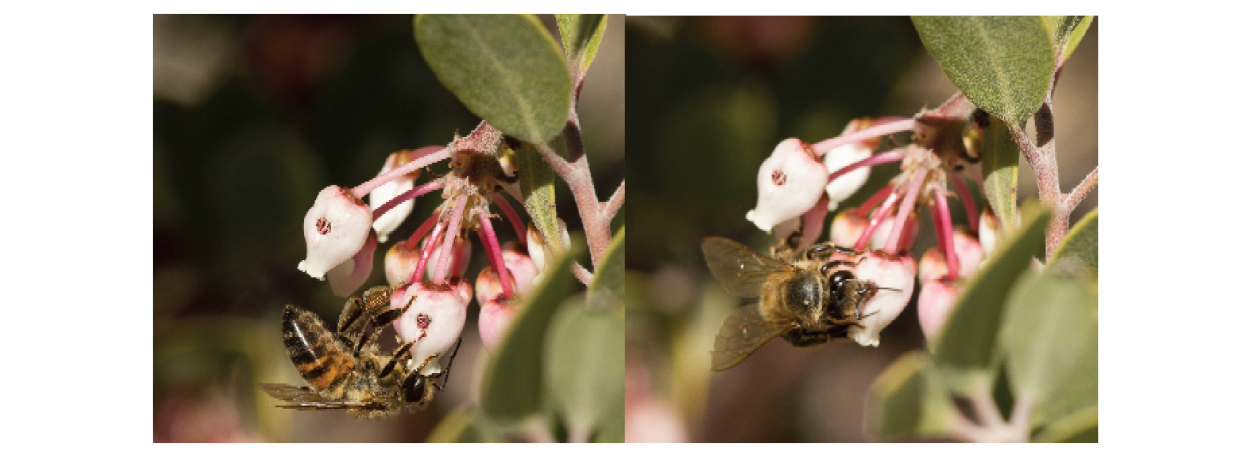
terrestris bumble bees consistently show a preference for